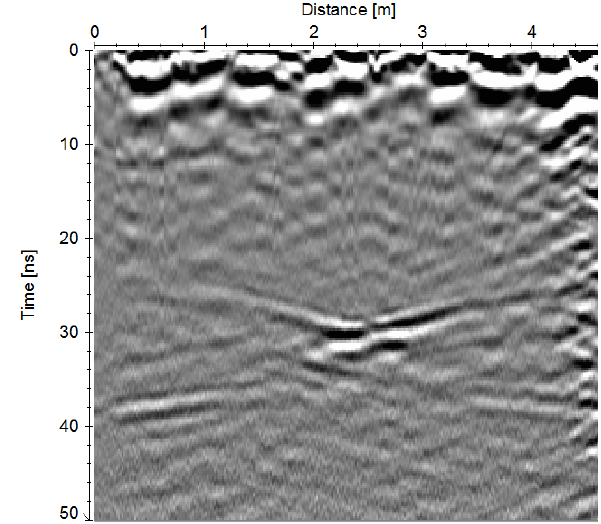
Figure 9. B-scan along the short side of the main nave of the Church of Santa